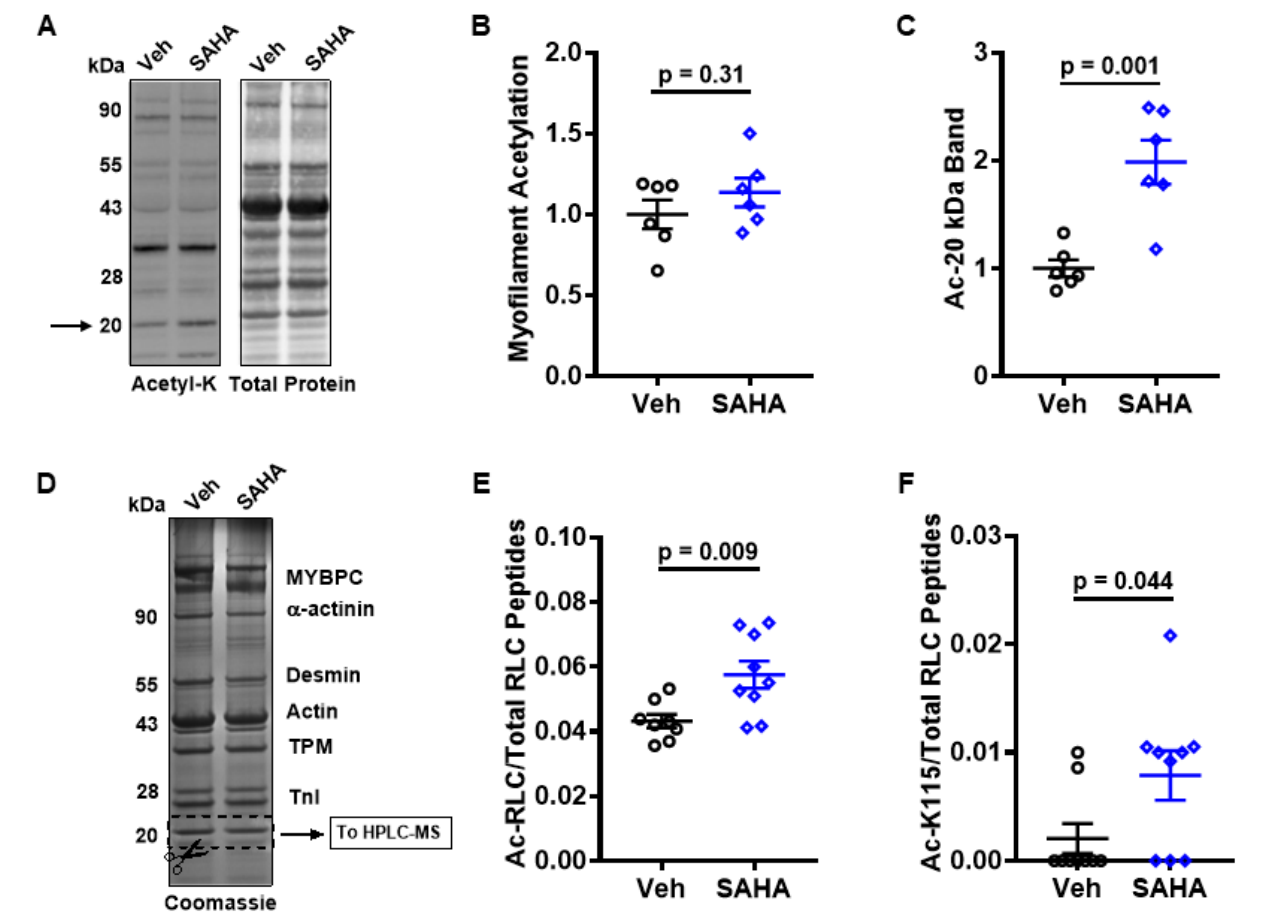
Figure 3. Effect of SAHA on myofilament acetylation. The myofilament acetylation was assessed in acutely treated AFVM ( A – F ). Western Blot analysis revealed that ( A , B ) total myofilament acetylation was not increased with SAHA treatment but there was significantly more ( C ) acetylation at a 20 kDa band (indicated with arrow in ( A )); n = 6 felines per group. ( D ) Coomassie staining was performed, and the band was cut out for mass spectrometry analysis, which revealed that this 20 kDa band with ( E ) increased acetylation is the myosin regulatory light chain with one ( F ) specific residue (lysine 115) driving the increase in acetylation; n = 3 felines per group, 3 technical replicates per sample. All analysis was performed using a two-sided Student’s t -test. * p < 0.05. Data shown are means ± SEM.